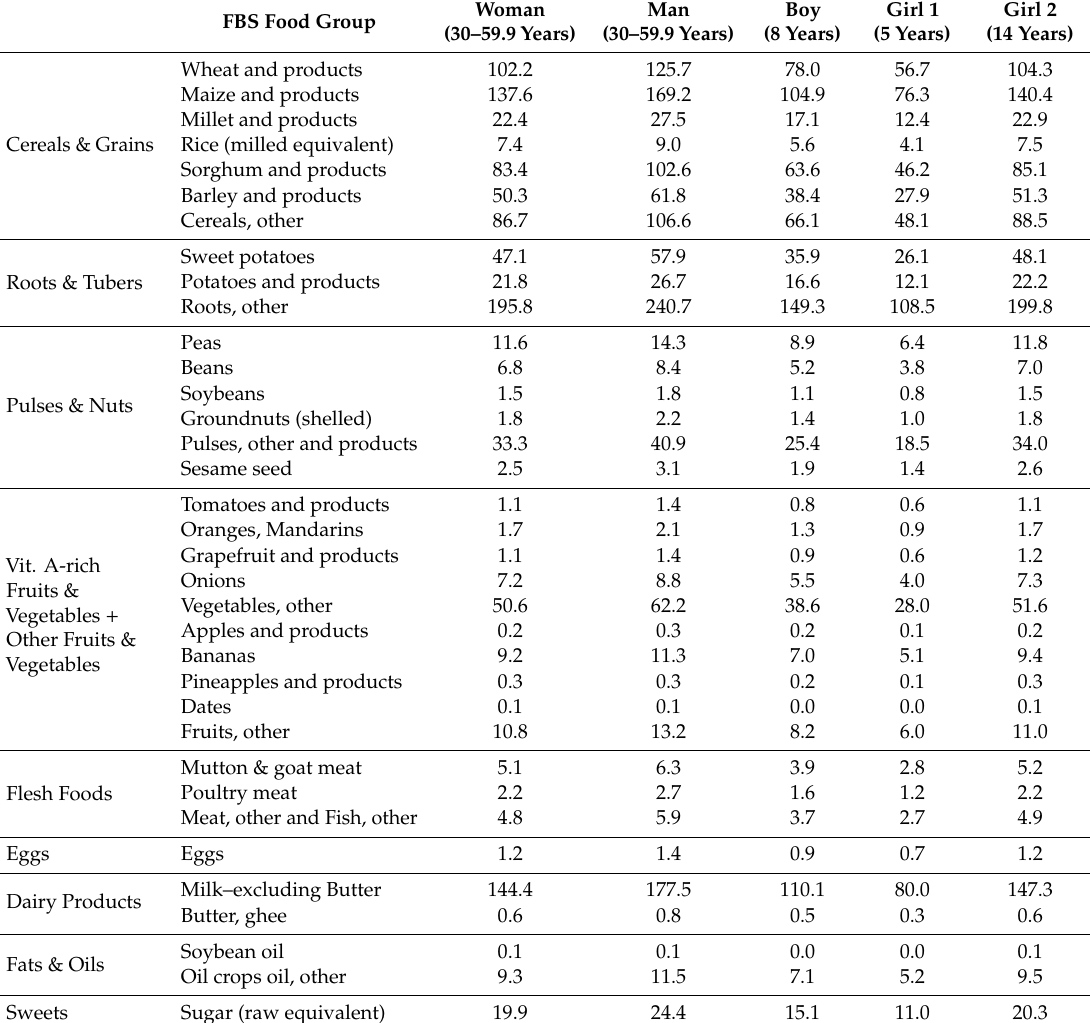
Table 2. Food supply pattern of an Ethiopian reference family as reported in the Food Balance Sheets (FBS) by FAO [33], adjusted for the individual EER [27]. The listed food amounts are in g /